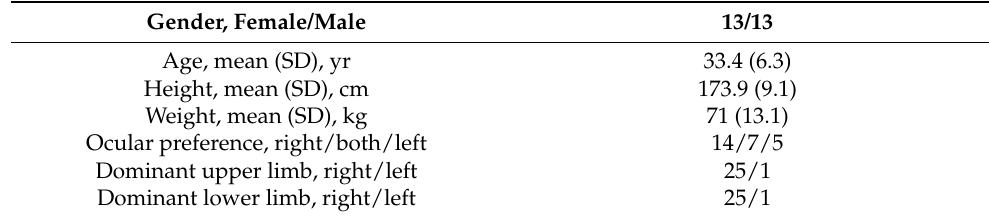
Table 1. Participants’ demographic data (N = 26). Gender, Female/Male 13/13 Age, mean (SD), yr 33.4 (6.3) Height, mean (SD), cm 173.9 (9.1) Weight, mean (SD), kg 71 (13.1) Ocular preference, right/both/left 14/7/5 Dominant upper limb,